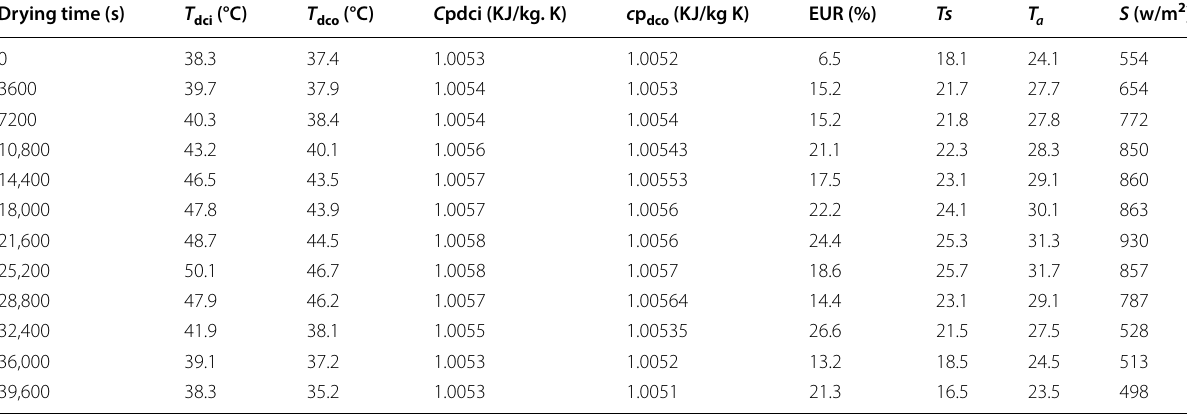
Table 20 Result energy analysis onion 2nd